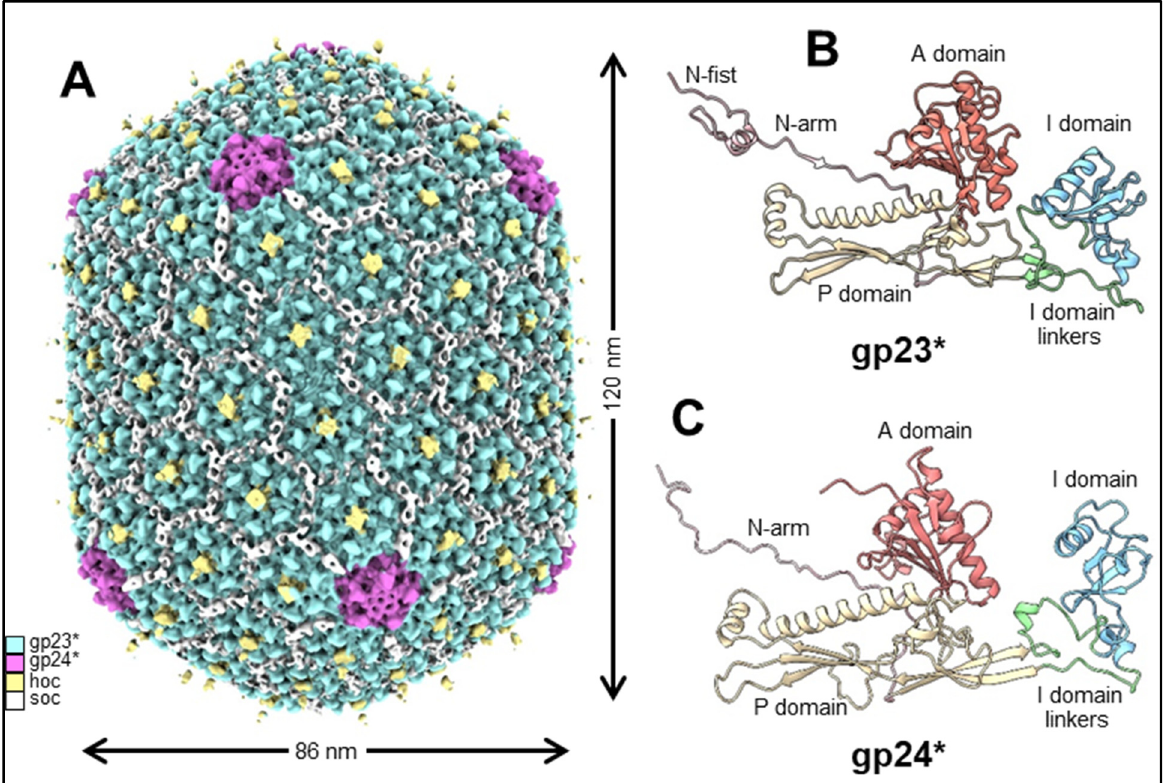
Figure 2. Structure of the mature phage T4 prolate head and the atomic models of gp23* and gp24*. ( A ) Cryo ‐ EM structure of the phage T4 prolate head (EMD ‐ 6323). Ribbon diagrams of gp23* ( B ) and ( A ) Cryo-EM structure of the phage T4 prolate head (EMD-6323). Ribbon diagrams of gp23* ( B ) and gp24* ( C ) (PDB ID: 5VF3) depicting the HK97 fold and the key subdomains. gp24* ( C ) (PDB ID: 5VF3) depicting the HK97 fold and the key